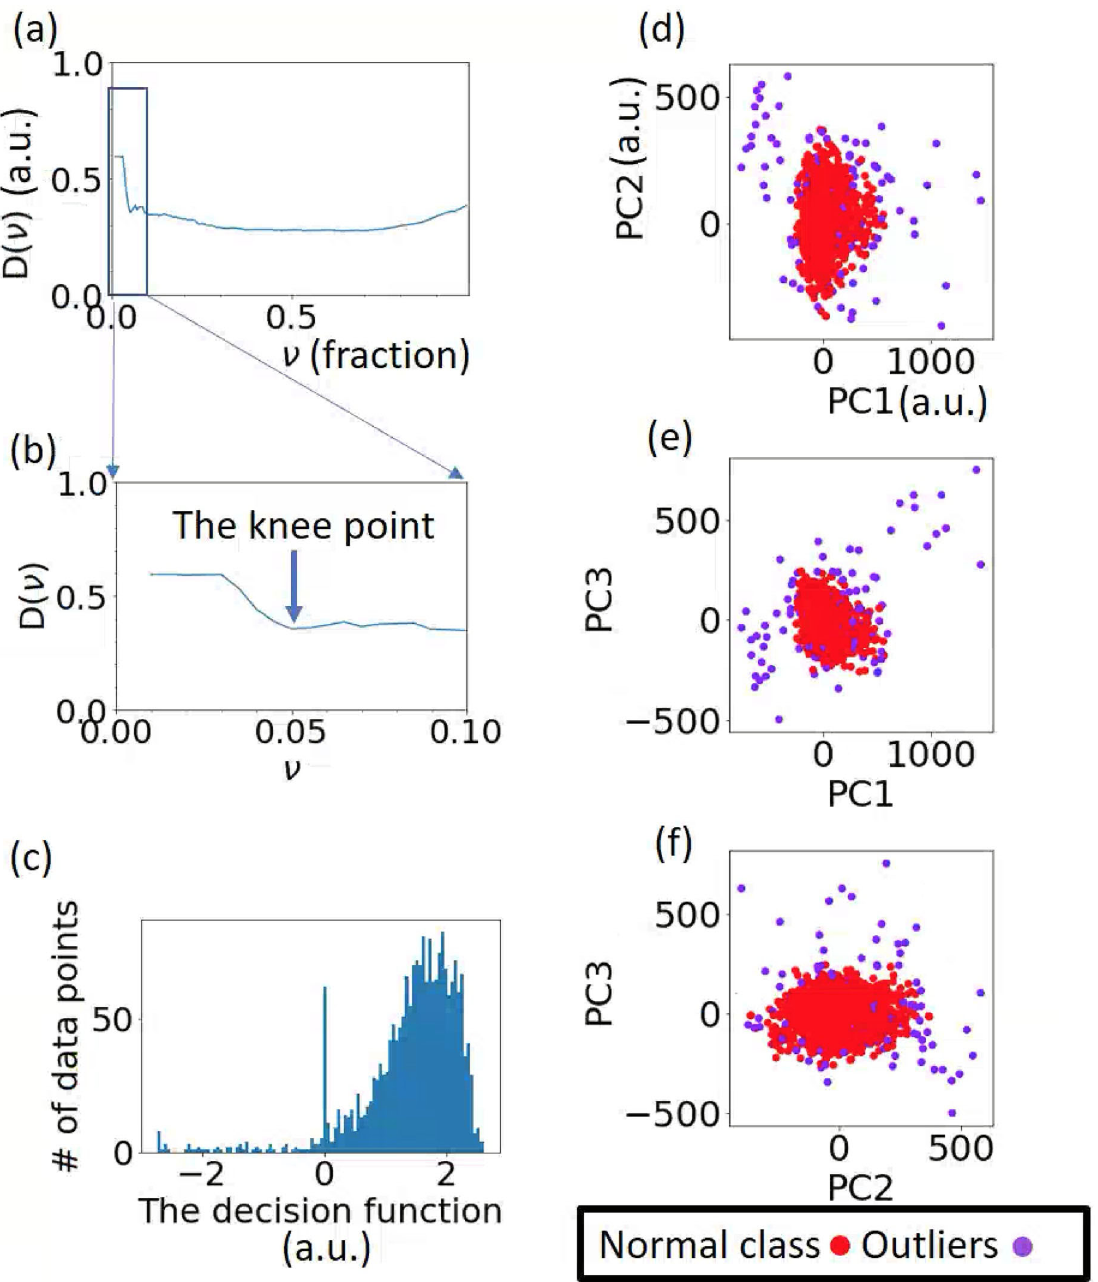
Fig. 3 Details of OCSVM analysis. a, b Upper bound on the fraction of outliers, the ν parameter, is chosen from knee point of the curve for distance between the median values of decision functions in the normal class and outliers, D ð ν Þ . c Histogram of decision function shows density of data points with different signed distances to the hypersphere (zero point at horizontal axis). Outliers lie on the negative side. d – f Distribution of data points in eigenspace of PCA. Axis labels, PC1, PC2, and PC3, are fi rst three signi fi cant principal components; outliers are labeled in